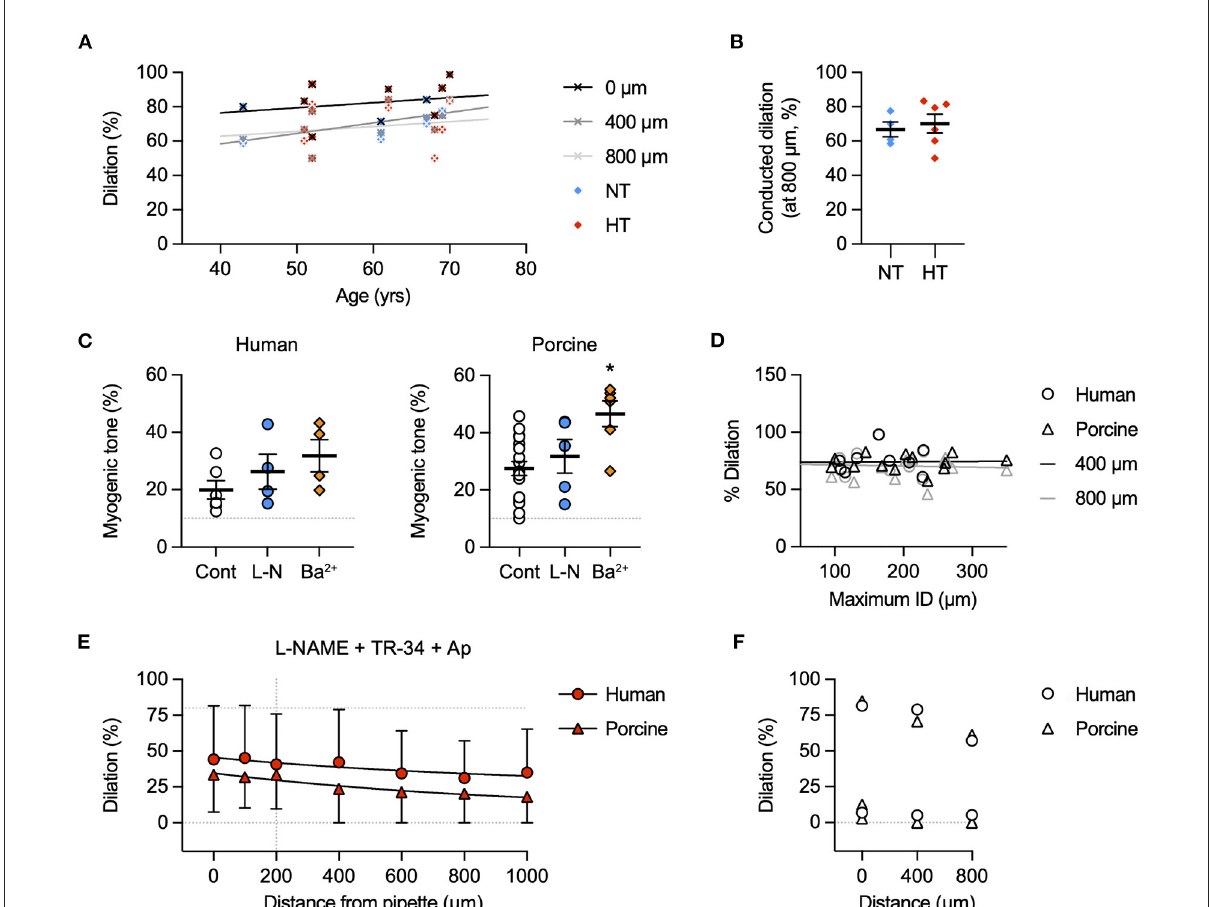
FIGURE4 Possible factors influencing conducted dilation. (A) Effect of patient age on conducted dilation to bradykinin in RA-IMCAs. Paired control data from Figure 3 for each patient are aligned with patient age. Simultaneous values for dilation at 0, 400, and 800 µ m are shown. There was no significant correlation with age in this cohort of 10 patients, each undergoing valve surgery. (B) Patients were separated according to whether they were being treated for hypertension (HT) or were normotensive (NT). There was no difference in conducted dilation at 800 µ m. Values are shown at the time point where the response at 200 µ m was 80% of maximum diameter (to normalize responses between patients). (C) Effect of inhibitors on baseline myogenic tone in human and porcine RA-IMCAs. Non-parametric mixed effects analysis with Dunn’s multiple comparison test; *, P < 0.05 vs. control. (D) Effect of RA-IMCA maximum inner diameter (ID) on the conducted dilation to bradykinin observed at 400 µ m and 800 µ m upstream from the delivery pipette. Paired control data from Figure 3 for each patient are aligned with maximum ID. (E) Effect of